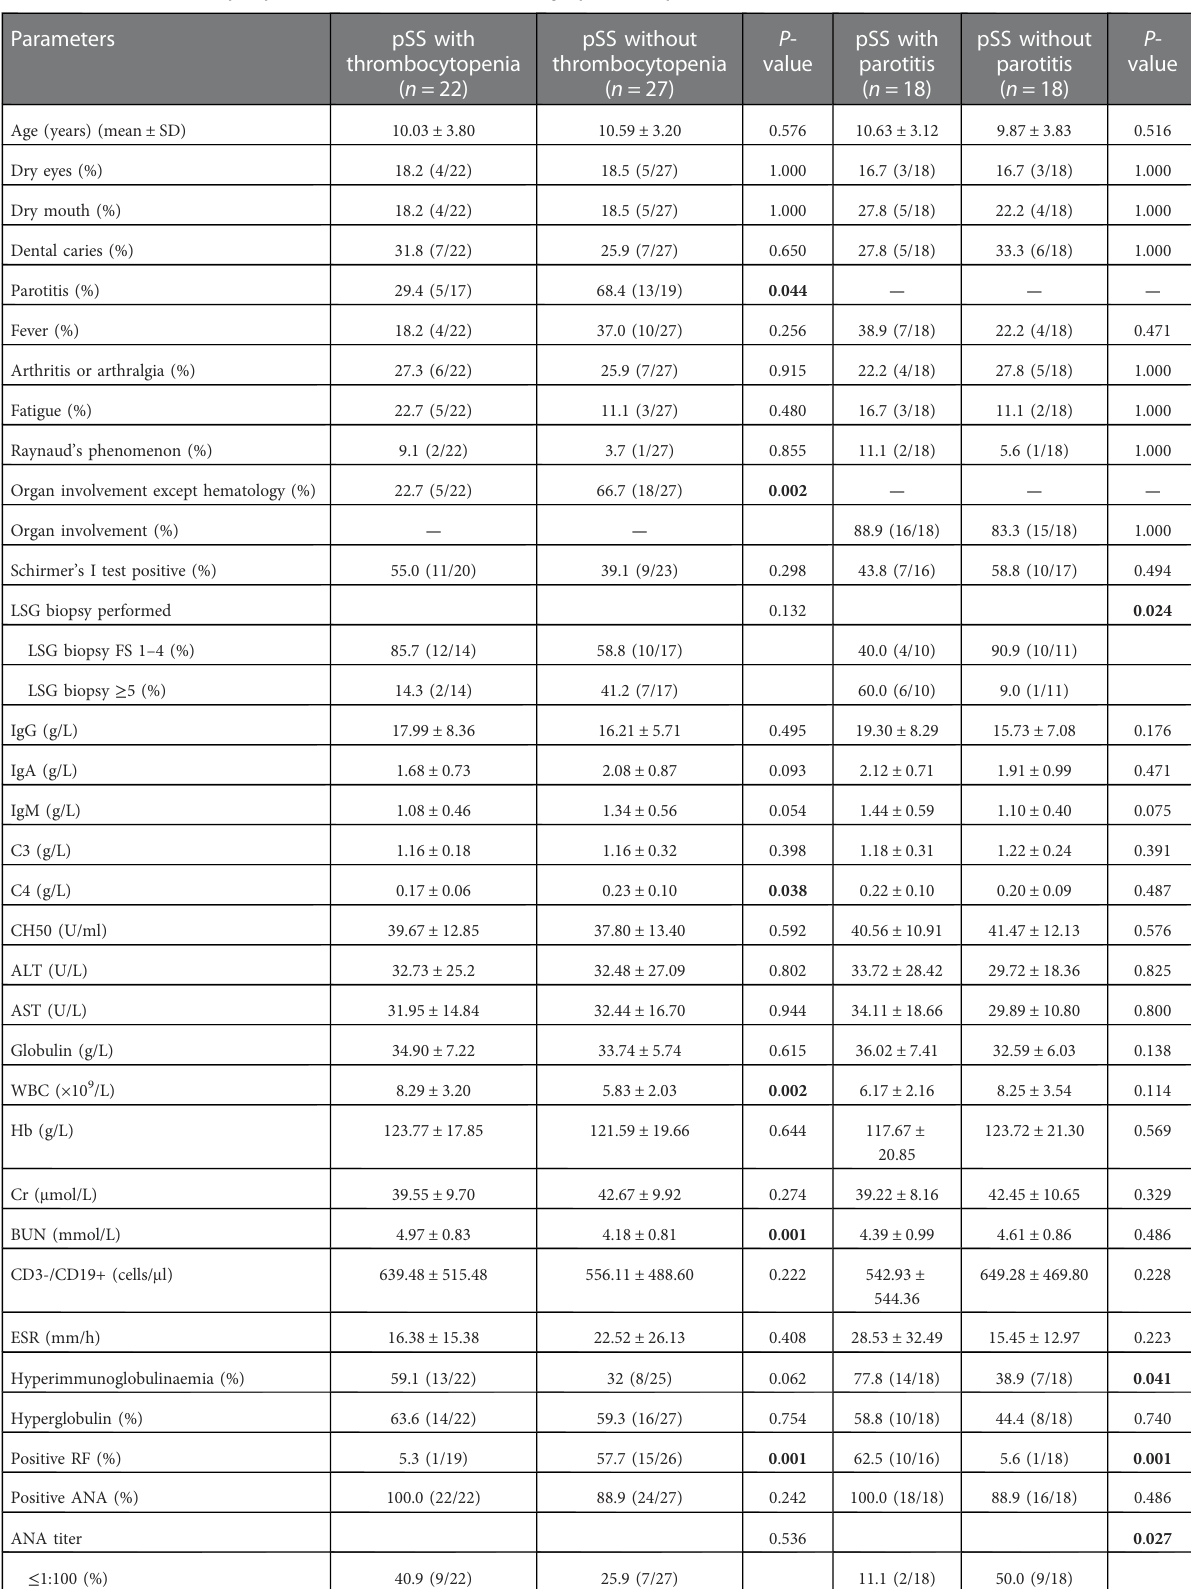
TABLE 2 Characteristics of pSS patients with or without thrombocytopenia and